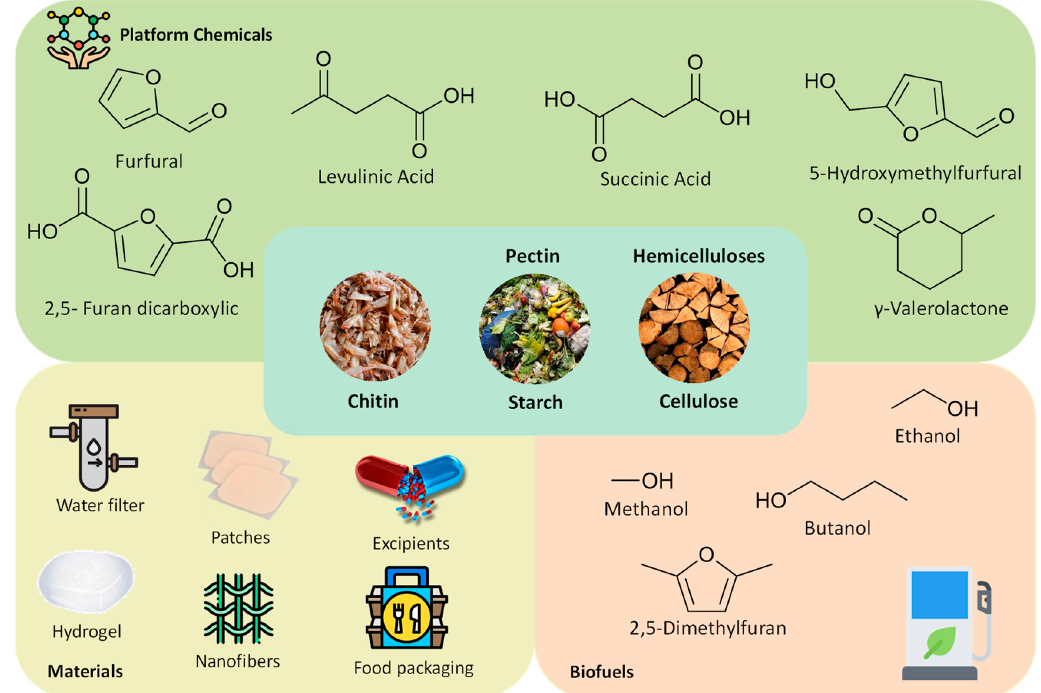
Figure 1. Examples of applications and products from biomass polysaccharides.